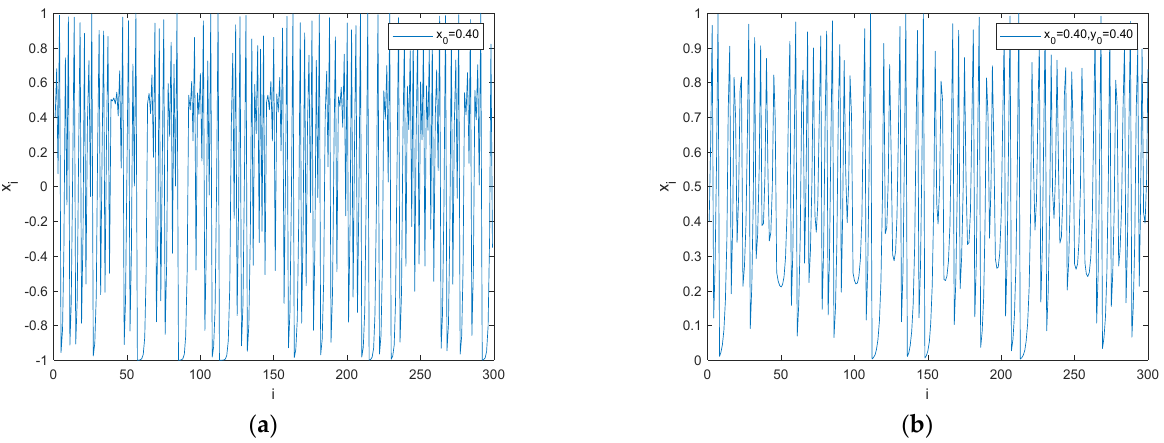
Figure 1. Time domain diagram. ( a ) Improved Logistic Map ( 𝑥 (cid:2868) = 0.40 , μ = 2); ( b ) 2D-Logistic map ( 𝑥 (cid:2868) = 0.40 , 𝑦 (cid:2868) = 0.40 , r = 1.19).